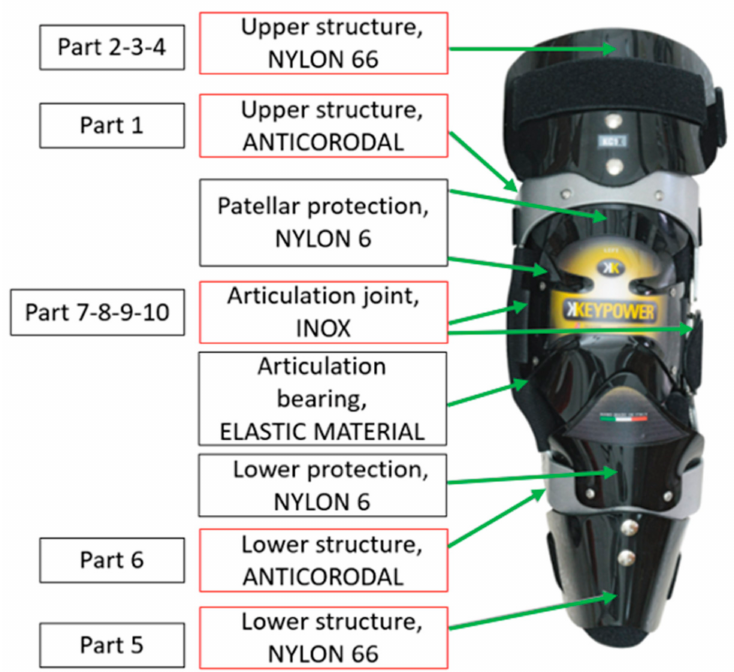
Figure 1. The sample of knee brace. The several structural and non-structural components are described, respectively, in the red and black boxes. Retrieved from: https://www.keypower.it/ stabilizzatore-xc1x/ (accessed on 3 March 2023).